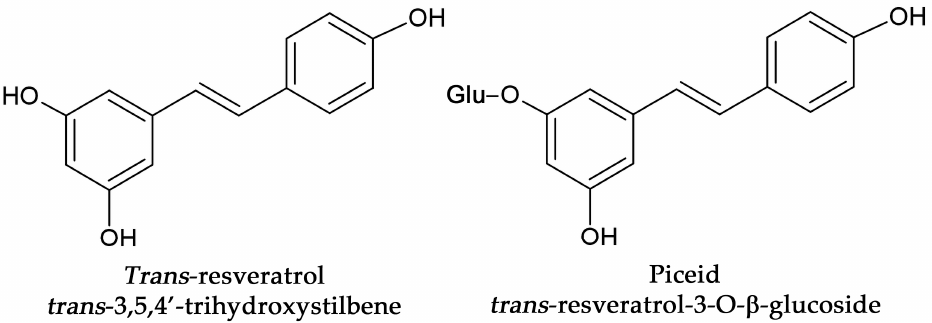
Figure 1. Structure of trans -resveratrol and trans -piceid.